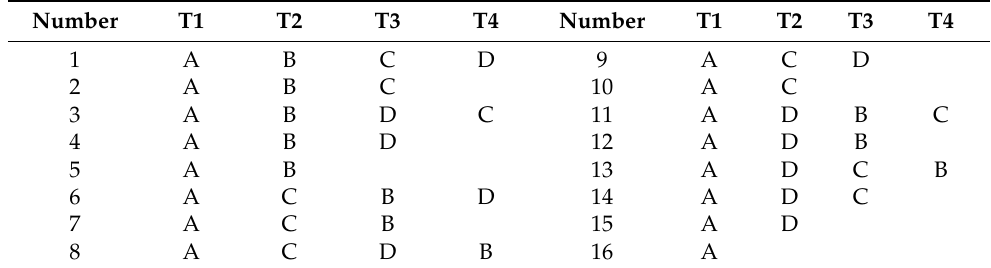
Table 1. Tank failure sequence.